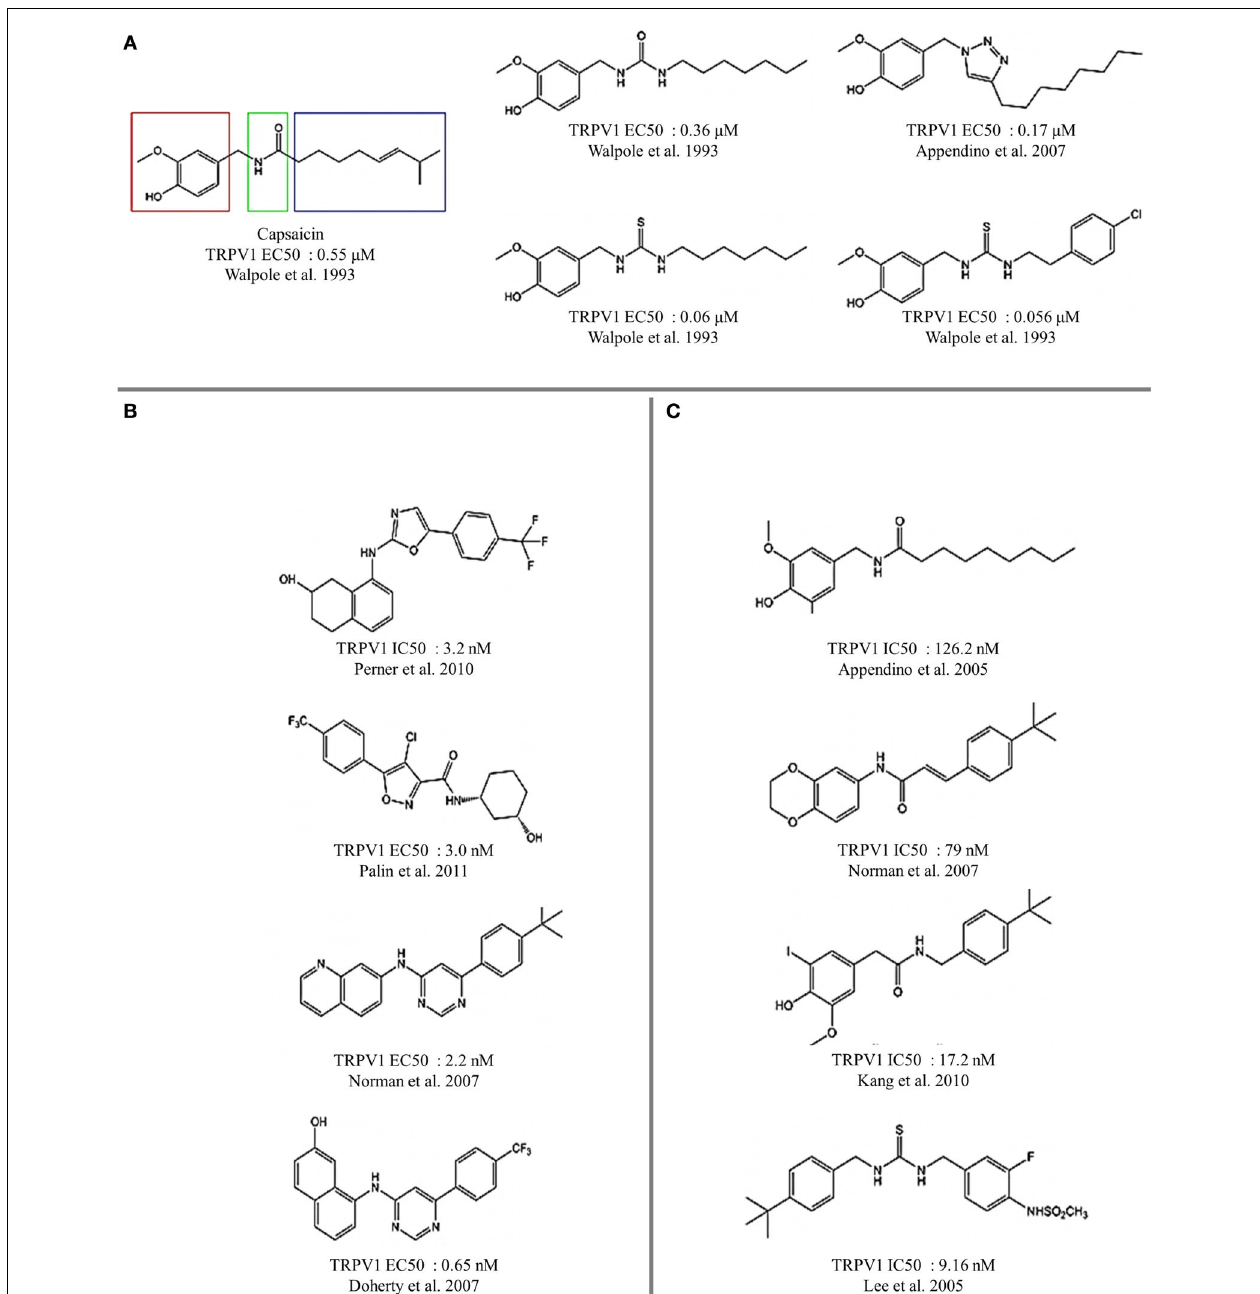
FIGURE 5 | Vanilloids and methylamines as thermoTRP channel ligands. (A) TRPV1 agonist activity. (B) TRPV1 antagonist activity. (C) TRP channel